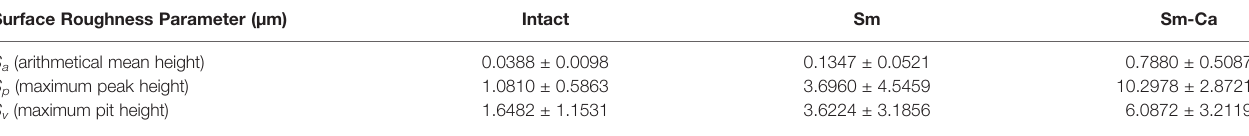
TABLE 2 | Surface roughness parameters of the demineralization of human enamel by bio fi lms. Surface Roughness Parameter (µm) Intact Sm Sm-Ca S a (arithmetical mean